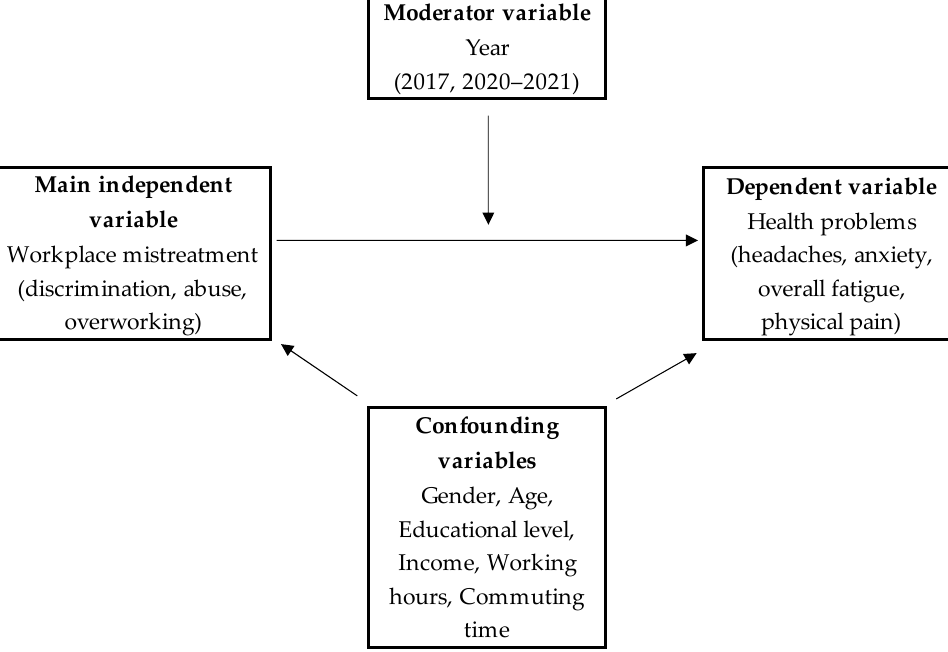
Figure 1. The theoretical model of the employed variables.